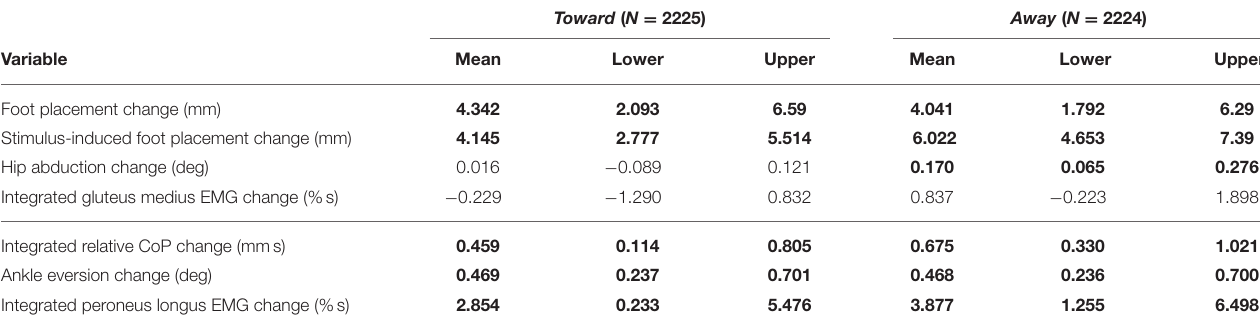
TABLE 3 | Least-squares means and upper and lower limits of the 95% confidence intervals for each outcome variable for stimulus toward and away from the triggering leg using Kenward-Roger